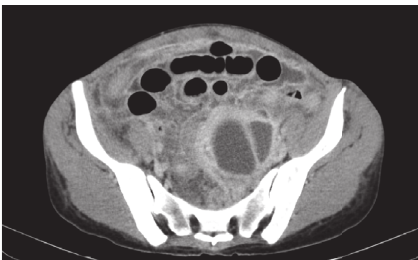
Figure 1: CT of pelvis demonstrating multiloculated abscess and dilated bowel loops.